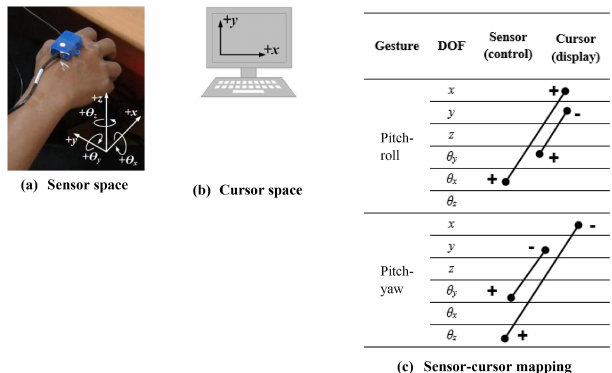
Figure 4. (a) Orientation of the sensor; (b) cursor space axes; (c) the sensor–cursor mapping: “ + ” and “ − ” signs correspond to the directions in (a) and (b)